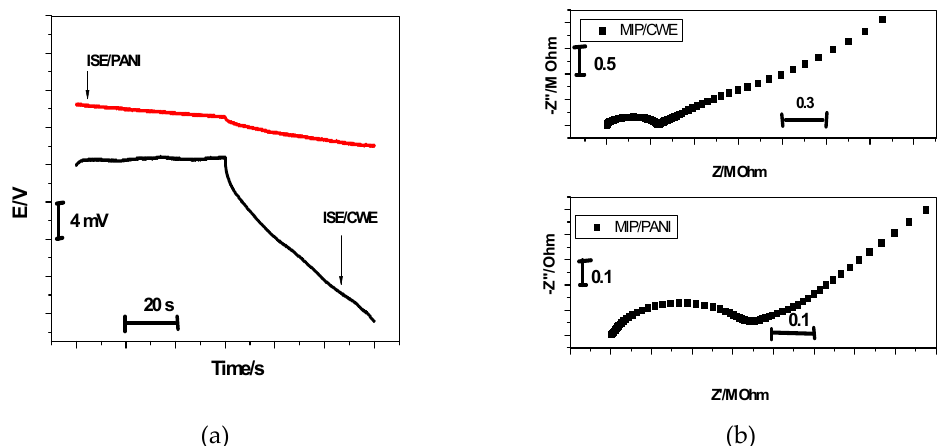
Figure 6. Chronopotentiometry ( a ) and Impedance plot ( b ) for bispyribac/MIP-ISEs with and without PANI as a solid contact material.